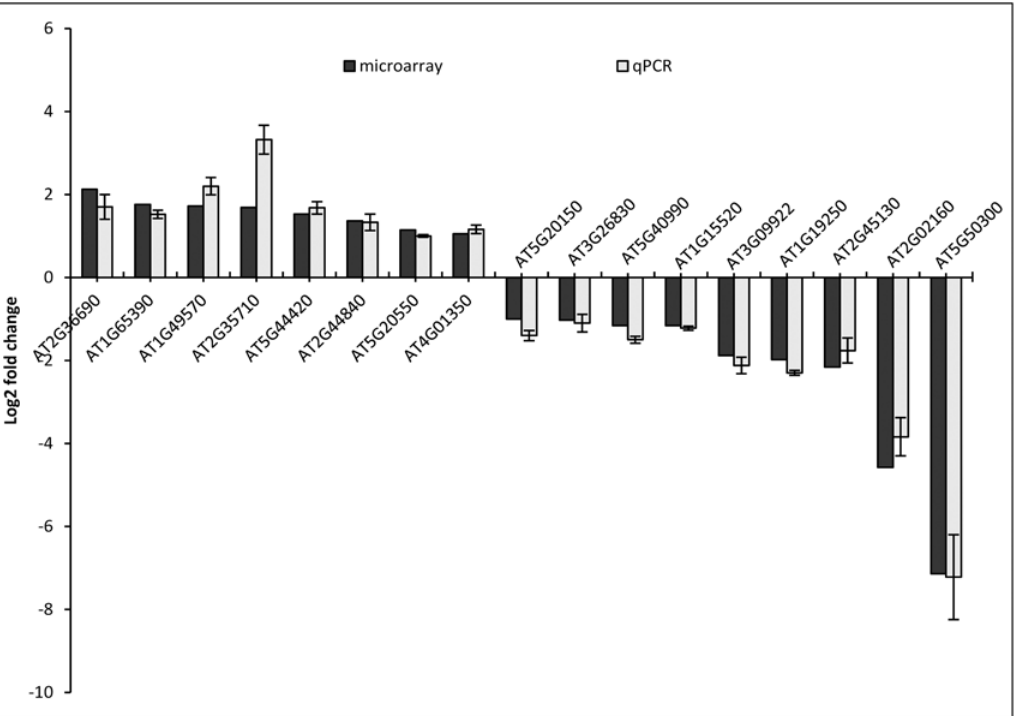
Fig 3. Validation and comparison of microarray results using qPCR for a few genes selected from each of the important biological processes. The experiment was carried out using biological triplicates and the values are presented as log2FC ± SE. (AT2G36690 – 2-OG; AT1G65390 — ATPP2-A5; AT1G49570 — peroxidase family protein; AT2G35710 — PGSIP7; AT5G44420 — PDF1.2; AT2G44840 — ERF13; AT5G20550 – 2-oxoglutarate; AT4G01350 — Cysteine/Hisidine-rich C1 domain family protein; AT5G20150 — SPX1; AT3G26830 — PAD3; AT5G40990 — GLIP1; AT1G15520 — PDR12; AT3G09922 — IPS1; AT1G19250 — FMO1; AT2G45130 — SPX3; AT2G02160 — CCCH type zinc finger family protein; AT5G50300 — AZG2.